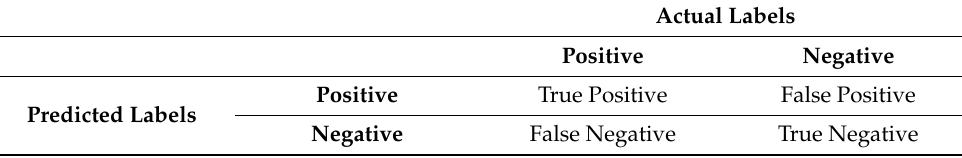
Table 4. Confusion